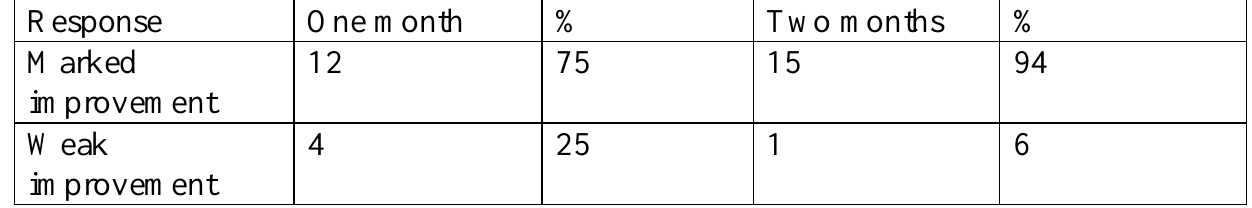
Table 2. The outcomes of 16 patients treated with pentostam within one-two months follow-up in dose 1 cc. daily for 6